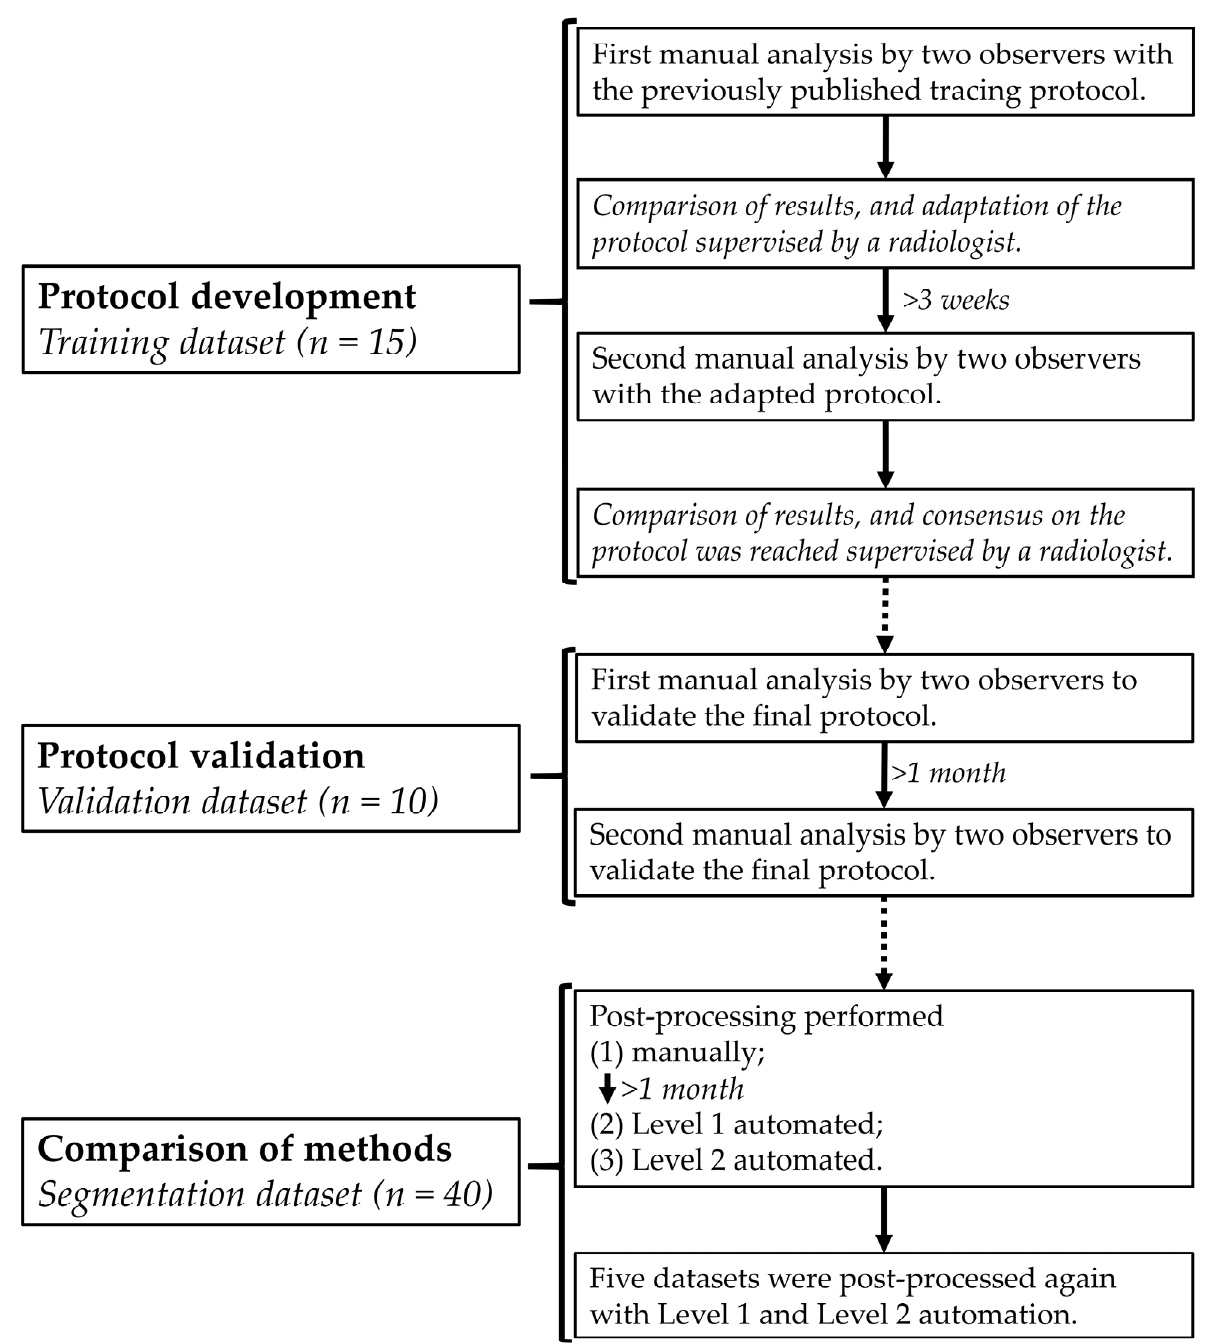
Figure 1. Flowchart of the study design.